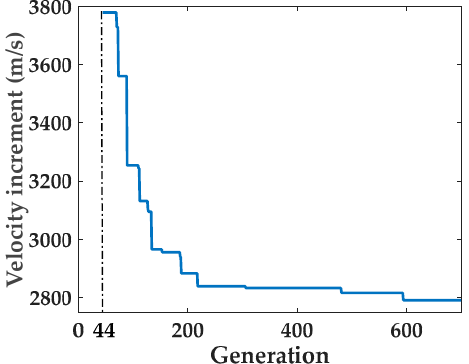
Figure 6. Evolution history of optimal solution. The time-varying processes of the semimajor axis, eccentricity, argument of perigee (AOP), and cumulative velocity increment of the SS are given, as shown in Figure 7. The vertical lines in the figure represent the inspection time of nine different targets. It can be seen that the semimajor axis and eccentricity of the SS increase gradually, and the greater the change of the two, the greater the velocity increment. The AOP almost remains in the range of 100–150°, which will reduce the fuel consumption in the aspects of changing AOP.